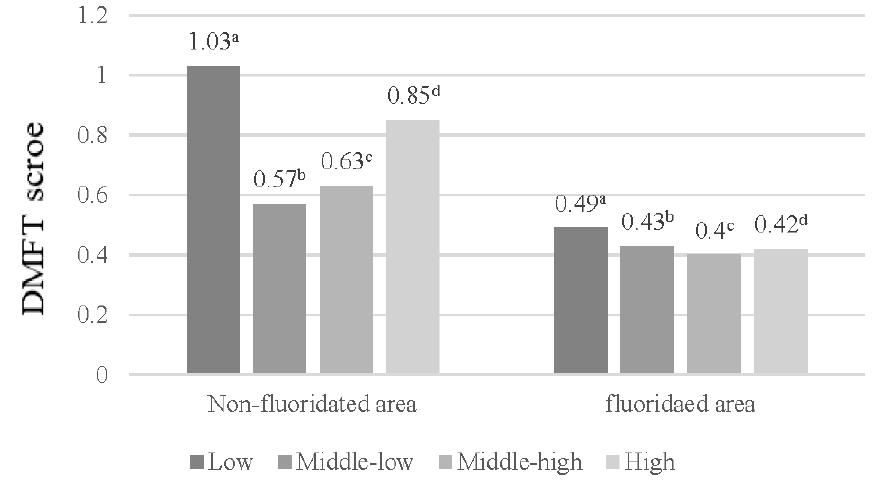
Figure 1. Distribution of decayed, missing, and filled teeth (DMFT) scores based on the monthly family income. The scores were calculated from the univariate analysis of variance: a Covariates appearing in the model are evaluated at the following values: age = 8.58; b Covariates appearing in the model are evaluated at the following values: age = 8.27; c Covariates appearing in the model are evaluated at the following values: age = 8.66; d Covariates appearing in the model are evaluated at the following values: age = 8.89.